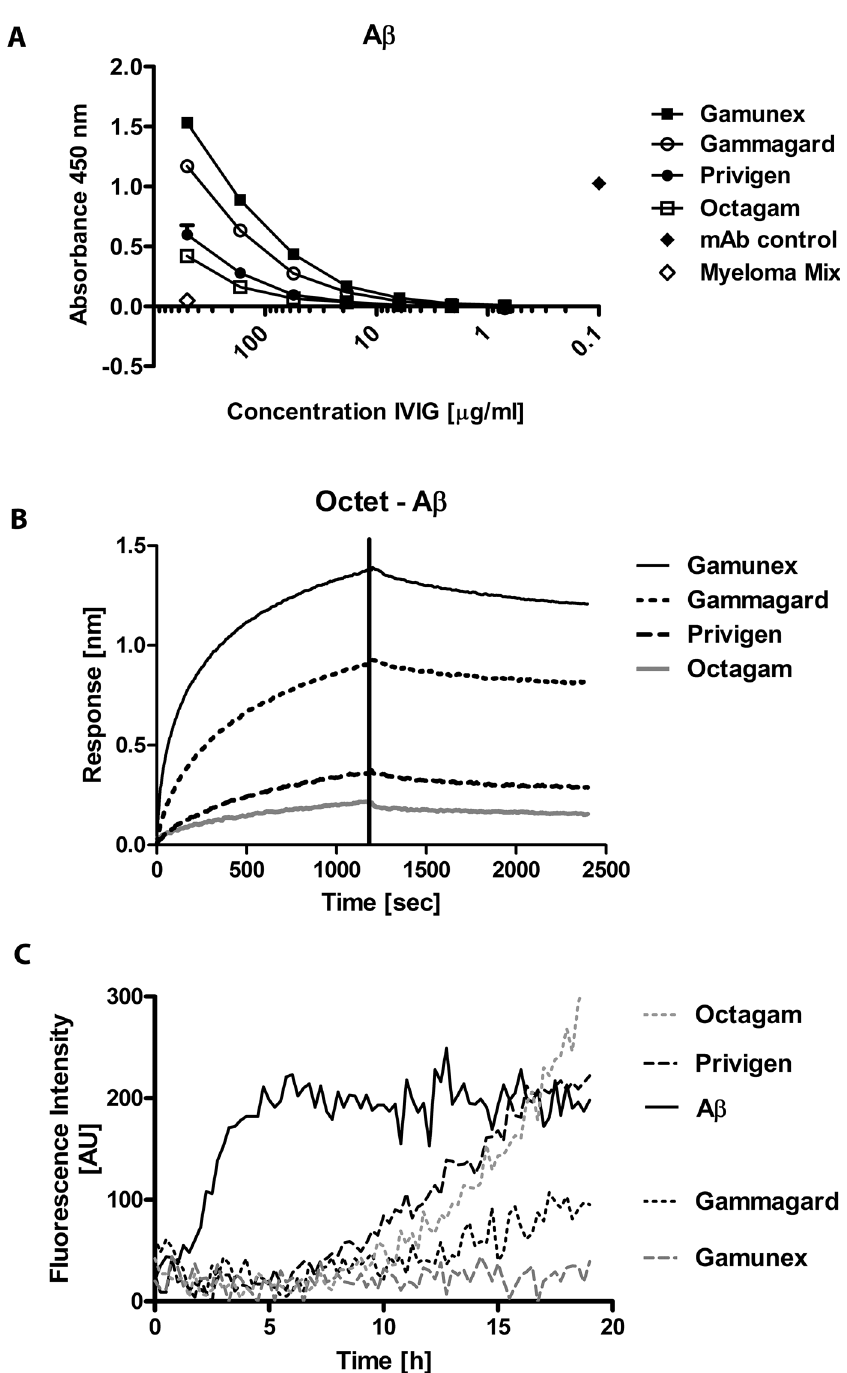
Fig 1. In vitro Comparison of commercial IgG preparations activity to A β by ELISA, Octet and Thioflavin T. (A) ELISA analysis of different commercial IgG preparations on plate-immobilized A β . (B) Octet measurements of the same commercial IgG preparations. (C) Inhibition of A β aggregation by different IgG preparations as measured by Thioflavin T fluorescence assay. The panel shows combined results from repeated measurements (n = 3) with different